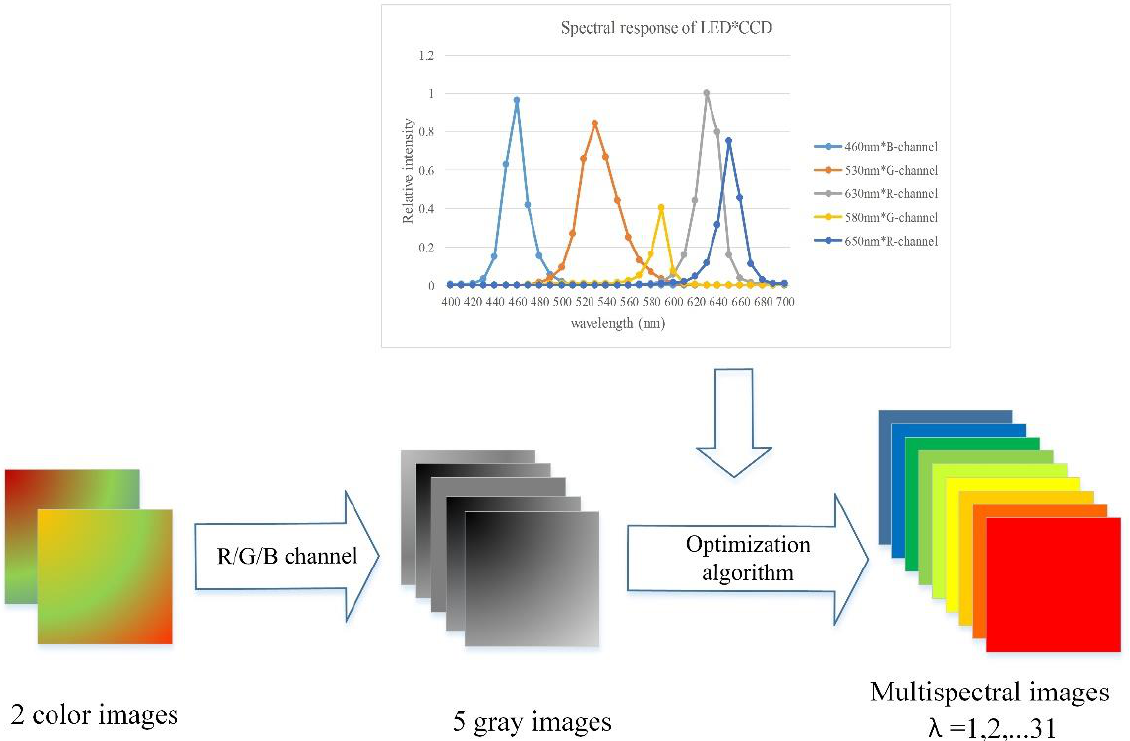
Figure 2. Reconstruction process from detected images to multispectral images.